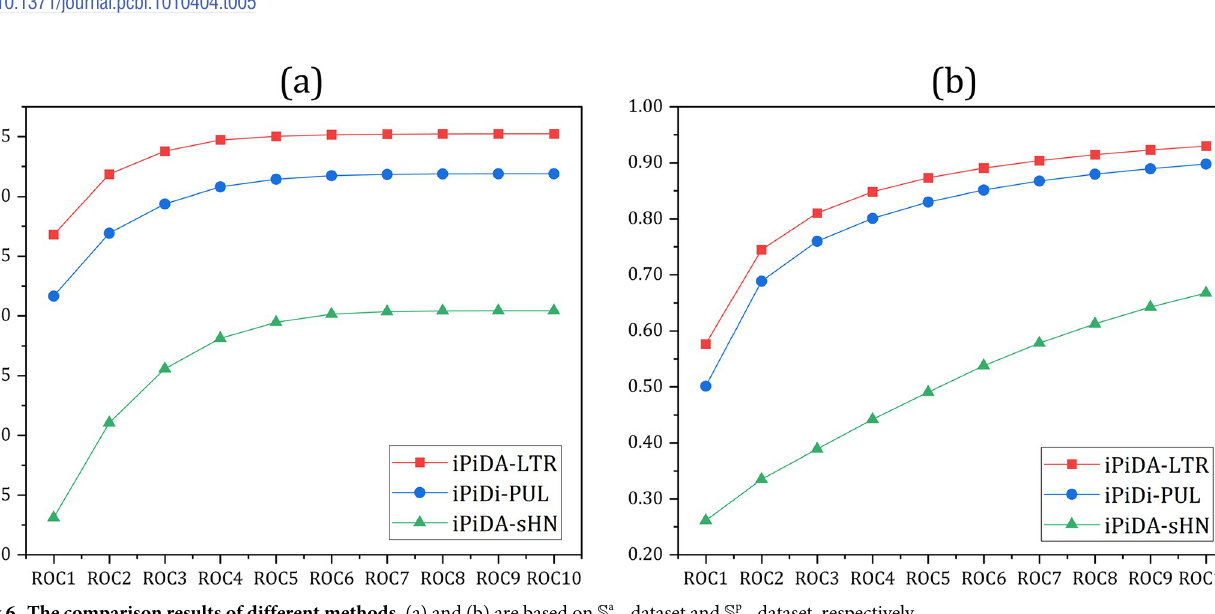
dataset. ind AUC AUPR